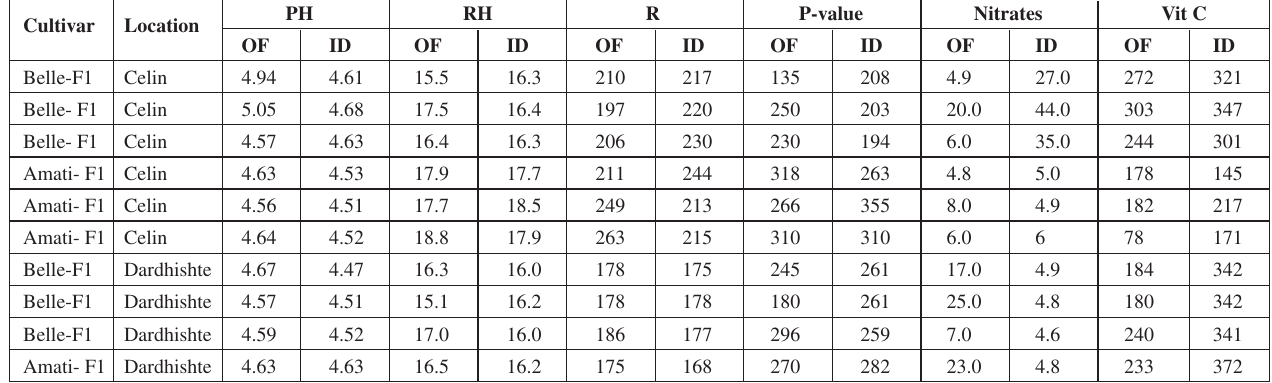
Table 1. Comparison of values for two different varieties of tomatoes, in two locations and two production environments (indoor & outdoor) for various parameters Cultivar